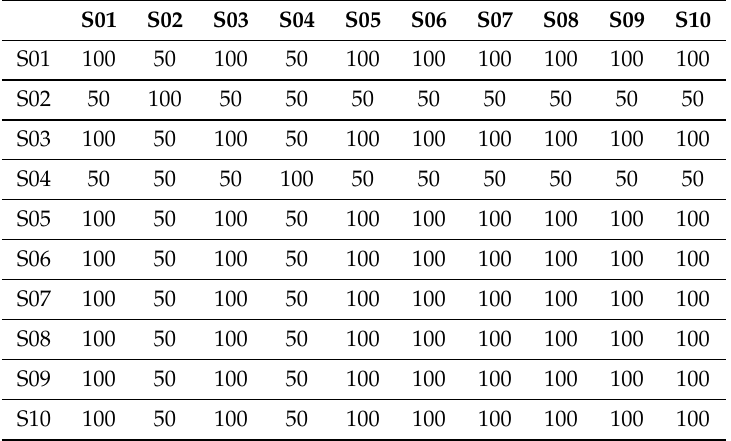
Table 24. Test results with ad-hoc signatures and SiSe.